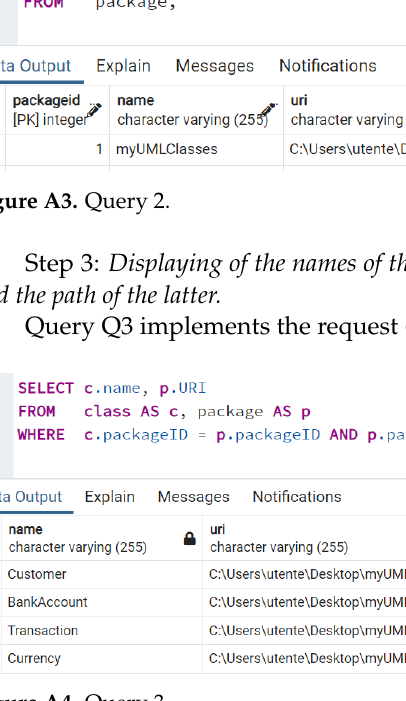
Figure A4. Query 3.